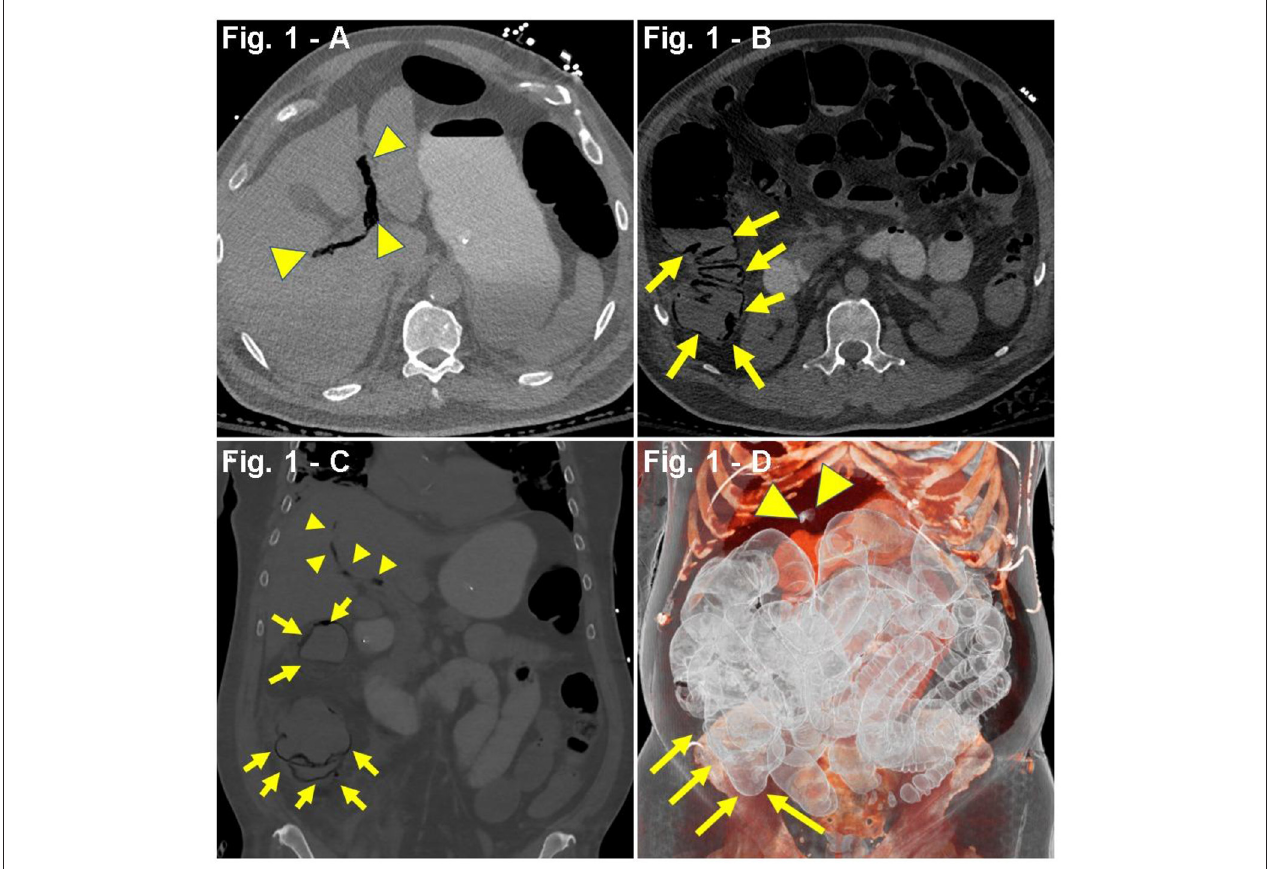
FIGURE 1 | (A–D) Case presentation of 65-year-old male patient with COVID-19, 5 days after tocilizumab (TCZ), non-contrast abdominal CT. (A,B) Axial, (C) coronal, and (D) 3D reconstruction, pneumatosis intestinalis (PI) involving ascending colon (yellow arrows), with dilated multiple right lower quadrant small bowel loops with mesenteric and portal venous gas (yellow